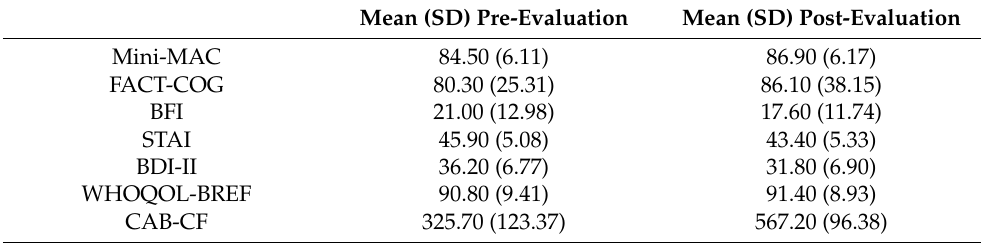
Table 3. Statistic descriptive at pre- and post-evaluation for all assessment